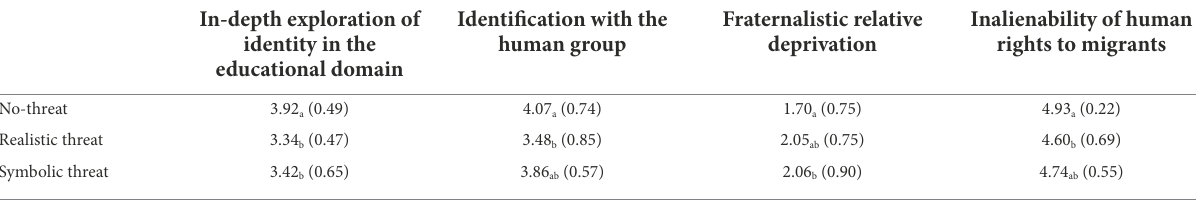
TABLE 2 In-depth exploration of identity in the educational domain, identification with the human group, fraternalistic relative deprivation, and inalienability of human rights to migrants as a function of intergroup threat.